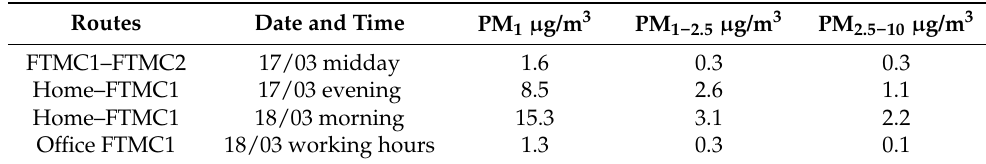
Table 1. Mean-size-segregated PM mass concentration in car cabin during the trips in Vilnius used as model